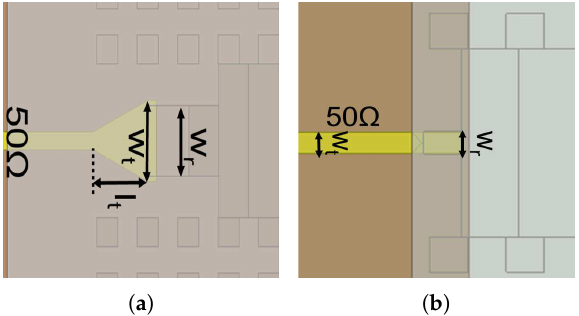
Figure 6. Microstrip to standard rectangular transition: ( a ) top view of the taper from a microstrip to a dielectric ridge gap waveguide; ( b ) top view of the microstrip to ridge gap waveguide transition.